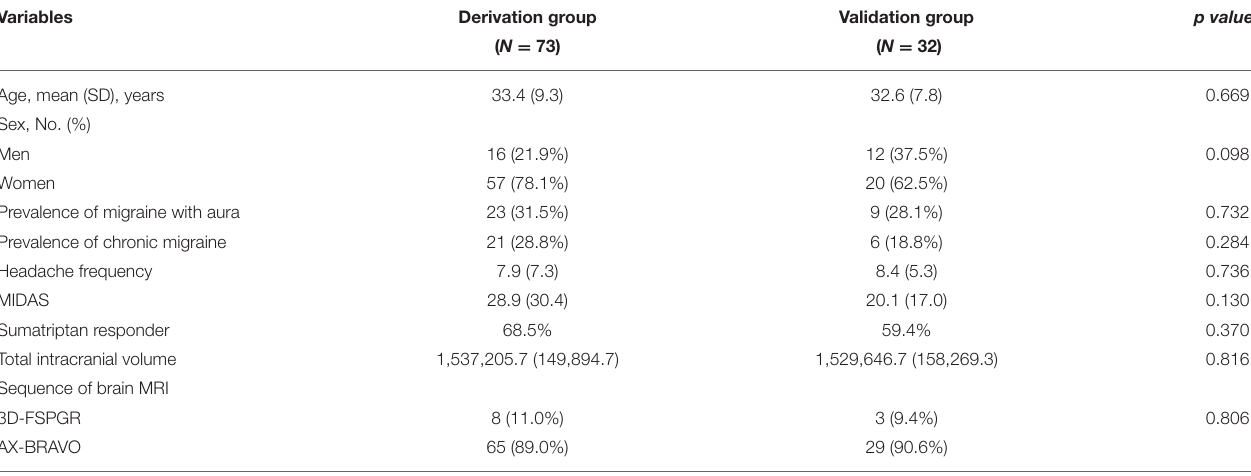
TABLE 1 | Demographics and descriptive statistics of potential confounding factors between the derivation and validation groups.